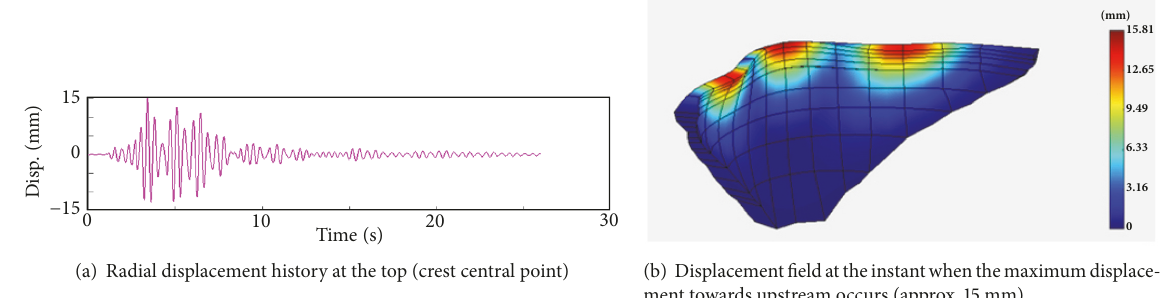
Figure 5: Computed seismic response of Cabril dam for a peak ground acceleration of 0.1g: displacement